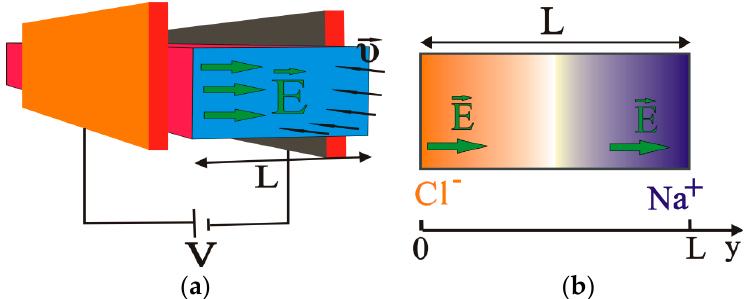
Figure 1. Flow configuration ( a ) and indicative salt ion distribution ( b ) of the present model.